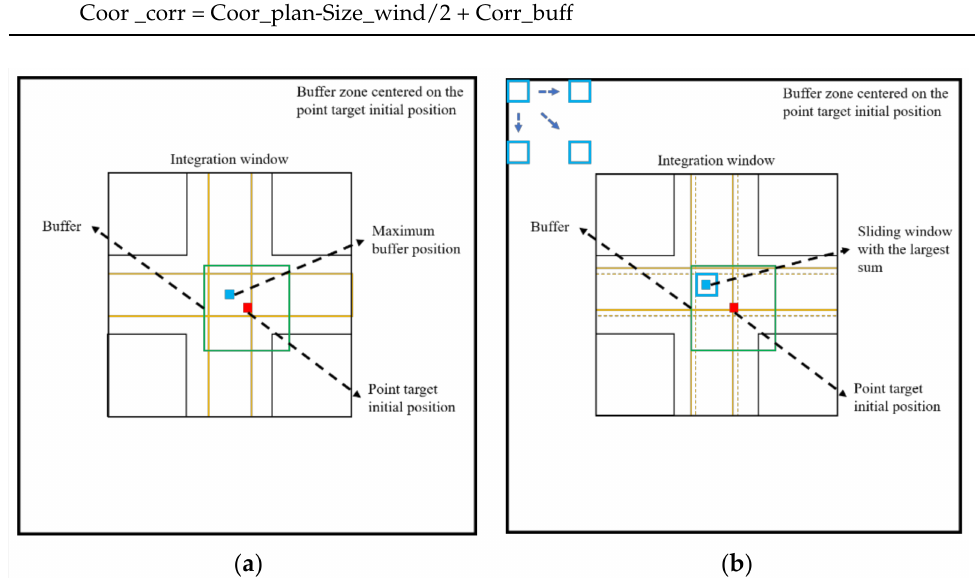
Figure 7. Schematic of the point target initial positioning method and integration window selection based on ( a ) the maximum center method and ( b ) the sliding window